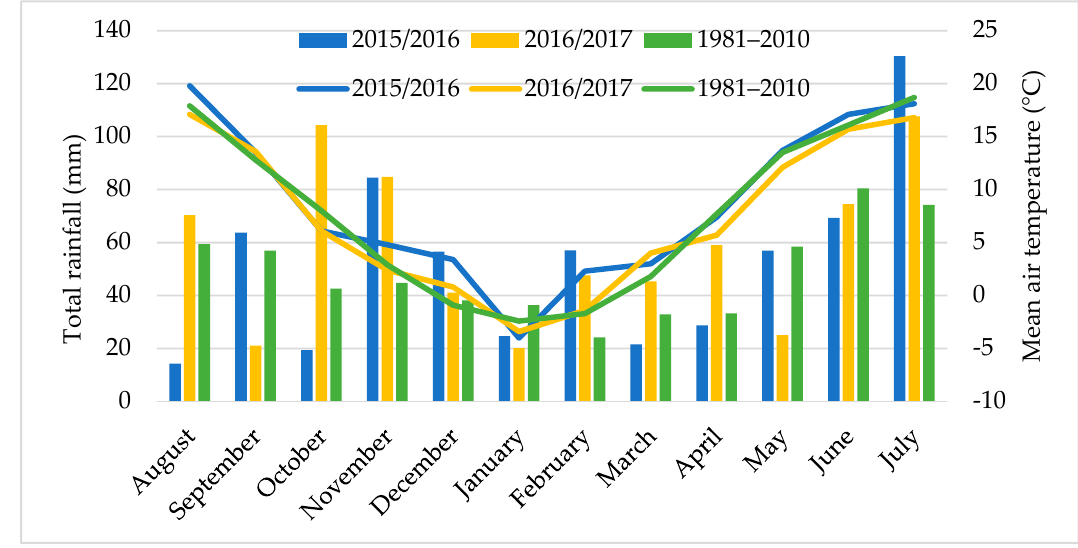
Figure 1. Weather conditions in 2015 ‒ 2017, and in the 1981 ‒ 2010 reference period, according to the Agricultural Experiment Station in Tomaszkowo (Bars refer to total rainfall and lines refer to mean air temperature).